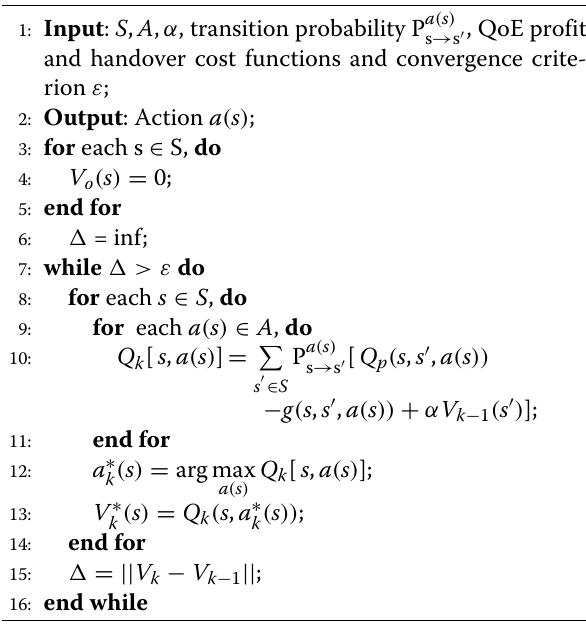
Algorithm 1 MDP-Based Q-VHO